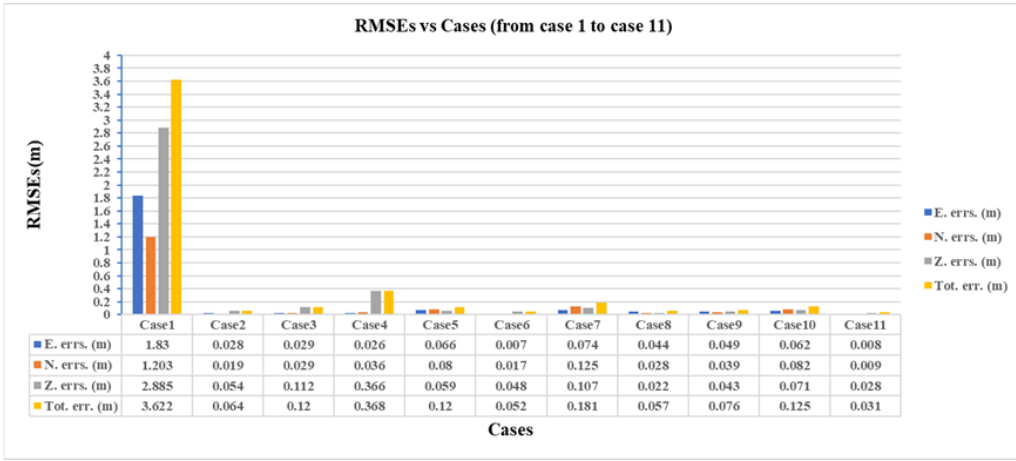
Figure 7. The RMSEs for the eleven cases.